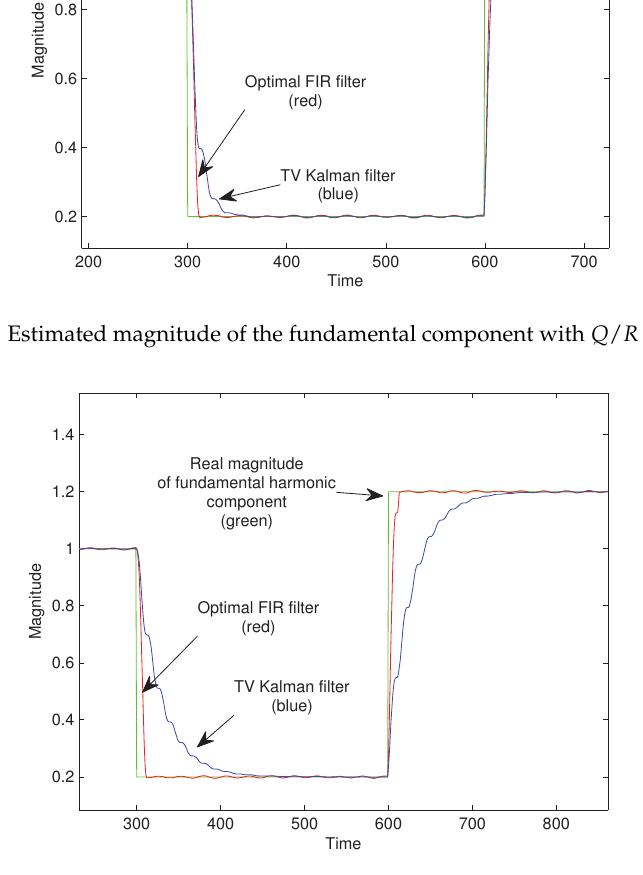
Figure 6. Estimated magnitude of the fundamental component with Q / R = 0.0025.